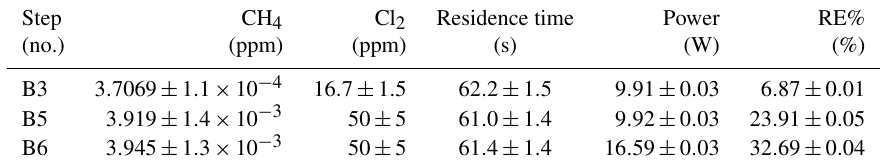
Figure D1. Exp. A–I are shown. Each illuminated step has been highlighted. (a) The CH 4 is seen as a function of time. The [Cl 2 ] is varied. (b) The light intensity and [Cl 2 ] are varied. (c) Steps 7–10 highlighted. The light intensity and t R are varied. (d) Steps 1–10 are highlighted. The light intensity and t R are varied. (e) Steps 1–16 are highlighted. The light intensity and [Cl 2 ] are varied. Following the initial illumination at 13W the sample was illuminated at three different p IN for five different chlorine concentrations. The p IN was of the order 13, 10 and 17W with chlorine steps 20, 40, 50, 60 and 70ppm. (f) Steps 1–7 are highlighted. The light intensity is varied. (g) Steps 1–12 are highlighted. The CH 4 level is varied, while the light intensity is kept the same. (h) Steps 1–9 are highlighted. The light intensity and t R are varied. (i) Steps 1–7 are highlighted. The light intensity is varied. Prolonged and stable photolysis was enabled due to cooling. Increasing levels of p IN for the photochemical chamber define the seven different steps. Table D5. Exp. B. The three experimental steps clearly show an increasing RE% as the p IN and the Cl 2 mixing ratio are